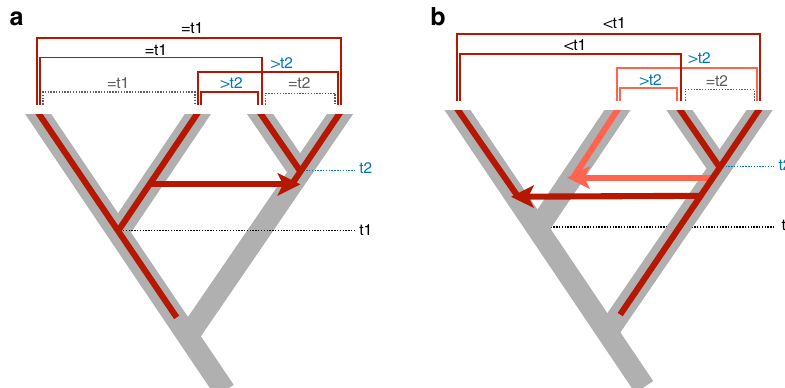
Fig. 1 Inferring horizontal transfers between two animal clades from homologies (hits) between transposable element copies. Species trees are drawn with thick gray branches, red branches representing phylogenies of TEs with HTT events shown as horizontal arrows. Hits between TE copies are represented by horizontal square brackets above tree tips, those re fl ecting vertical inheritance of TEs (hits within clades) are represented as dashed brackets. t1 and t2 represent the divergence of species within clades. a A single HTT event should result in similarities between TEs of different clades (shown above hits) that are lower than the similarities of TEs (and of species, as estimated from synonymous divergence at orthologous genes) within at least one of the clades. b The divergence time (inferred from DNA sequence divergence) between TEs from the different clades is always lower than species divergence within the oldest clade (t1). These hits cannot result from a single HTT event, even though divergence of TE copies within the right-hand clade can be lower than that of copies between